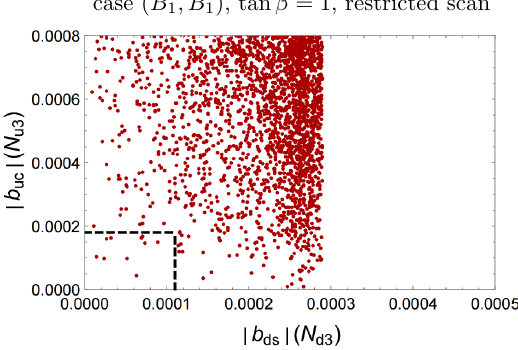
Figure 4 . The values of | b uc | , | b ds | obtained from N u 3 , N d 3 in a restricted scan with θ max = π/ 100 . case ( B 1 ,B 1 ), tan β = 1, full scan